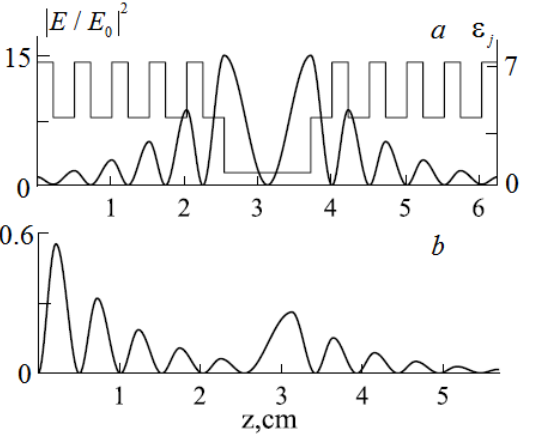
Figure 3. Field distribution over the MCR structure with the cavity of thickness L 3 = λ 0 /2; λ 0 /4 ( a , b